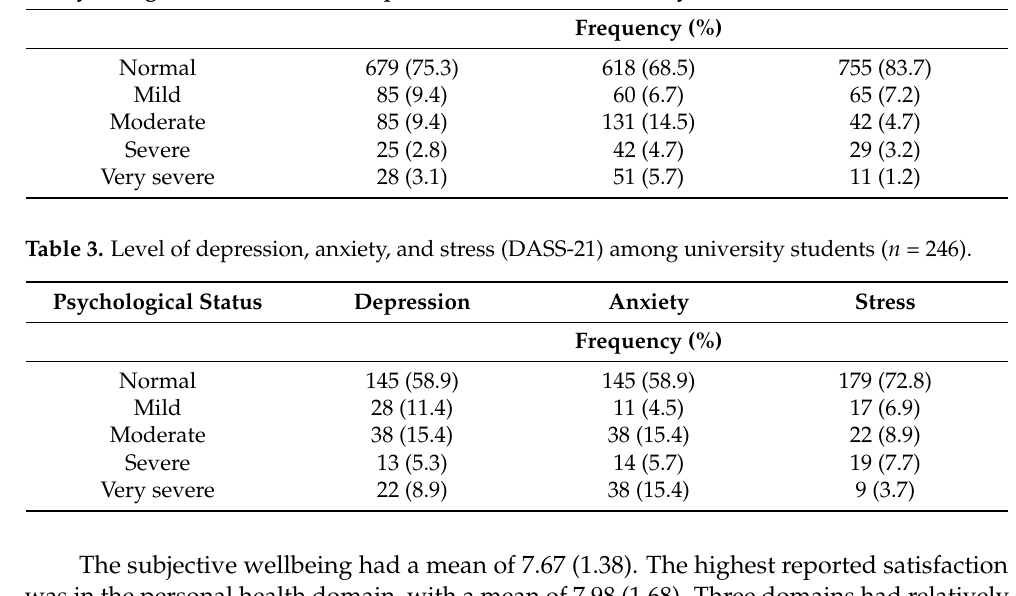
Table 2. Level of depression, anxiety, and stress (DASS-21) among university staff ( n = 902). Psychological Status